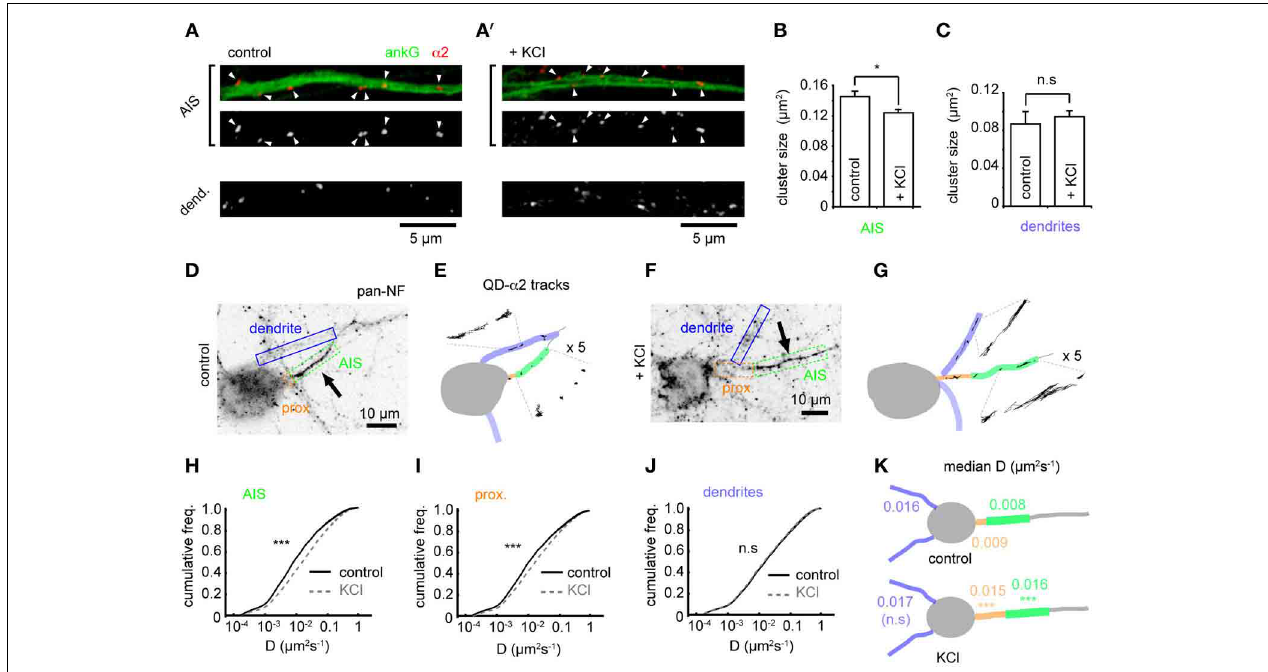
FIGURE 3 | Changes in GABA A R cluster size and lateral mobility at the (A) , overlaid with QD- α 2 tracks. (F,G) As in (C,D) for KCl-treated neuron. AIS in response to chronic depolarization. (A) α 2 clustering in AIS and (H–J) Instantaneous α 2-GABA A R diffusion coefficient in control (black) and KCl conditions (gray, dashed) in AIS (H ), proximal axon (I) and dendrites (J) . dendrites from control neuron. Top panel: AIS, ankG (green), α 2 (red). Control, 97 cells; KCl, 111 cells; 10 experiments. In the AIS, median D Arrowheads: clusters in AIS. (A (cid:2) ) As (A) , for KCl-treated neuron. (B) = 0 . 03, α 2-GABA increased 2-fold, n control = 40 , 681, n KCl = 49 , 235, p < 2 × 10 − 16 ; in the A R cluster size in the AIS is decreased by KCl treatment ( p n = 5 experiments). ( C) α 2-GABA A R cluster size in dendrites is unaffected proximal axon, median D increased 1.7-fold, n control = 11 , 314, n KCl = 19 , 979, ( p > 0 . 05). (D) As Figure 1F . Neurofascin live labeling delineates the AIS p < 2 × 10 − 16 ; in dendrites, lateral mobility was unaffected, n control = 316 , 962, n KCl = 463 , 969, p > 0 . 05. (K) Summary of median instantaneous (boxed in green). Proximal axon (orange) and dendrites (blue) can also be α 2-GABA identified from background staining. (E) Map of subcompartments shown in A R diffusion coefficient in control and KCl